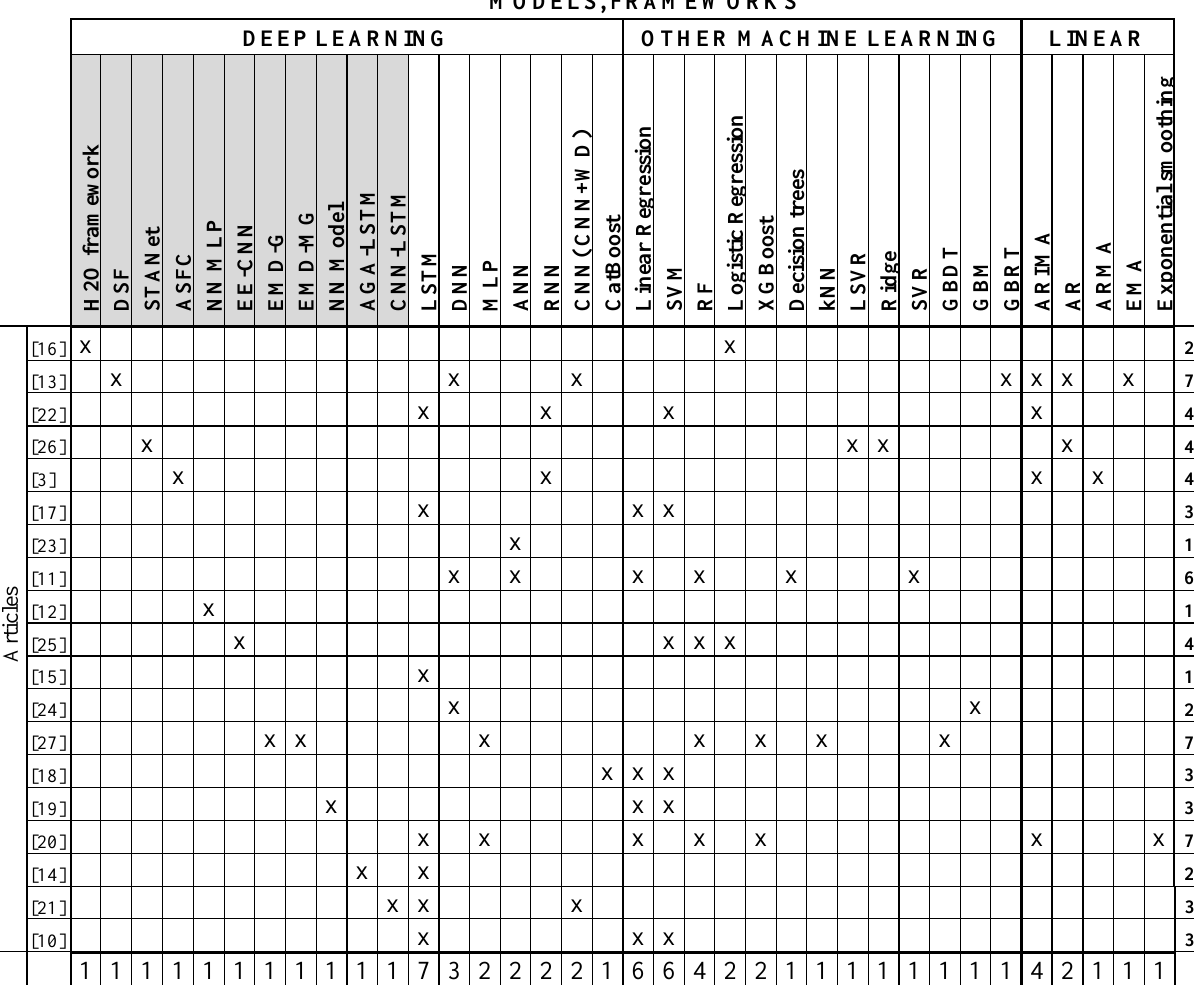
Table 2. List of models used in reviewed